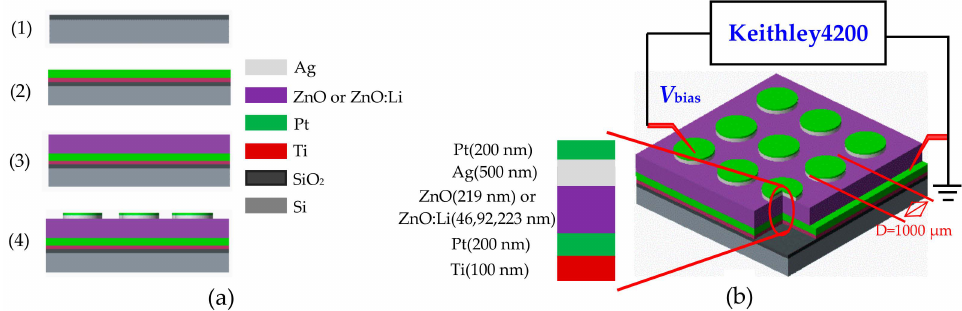
Figure 1. ( a ) Main fabrication process of Pt/Ag/ZnO:Li/Pt/Ti resistive switching device; ( b ) The basic structure and measurement configurations.